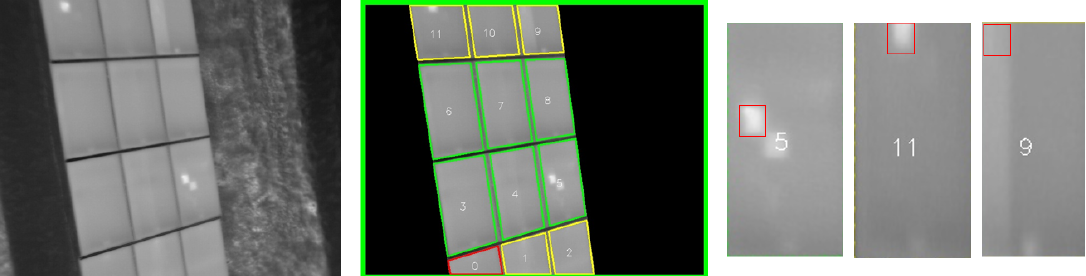
Figure 16. Error detecting and classifying the thermal